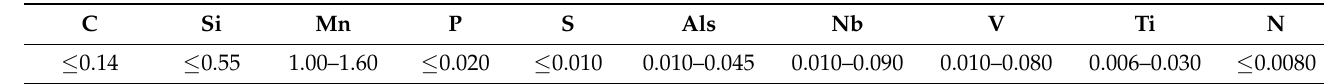
Table 1. The chemical composition of Q370qD(%) [26].